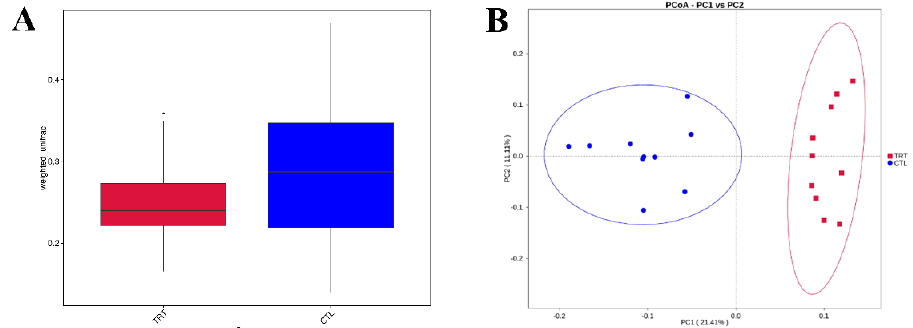
Figure 3. Dietary silymarin supplementation modulated microbiota beta diversity in lactation sow. ( A ) Beta diversity analysis based on Weighted Unifrac distance. ( B ) Principal coordinates analysis of each sample based on unweighted UniFrac metric. n = 10. CTL, sow fed the basal diet; TRT, sow fed basal diet with silymarin 40 g/d from late gestation to lactation.